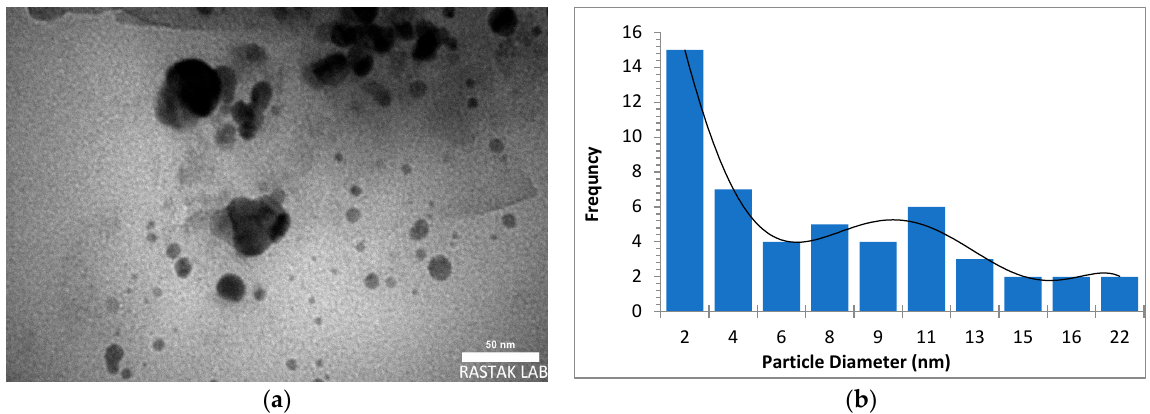
Figure 4. ( a ) TEM image of palladium nanoparticles (Pd NPs) prepared by pulsed laser ablation of palladium target in distilled water at 6.12 J/cm 2 , ( b ) size distribution.